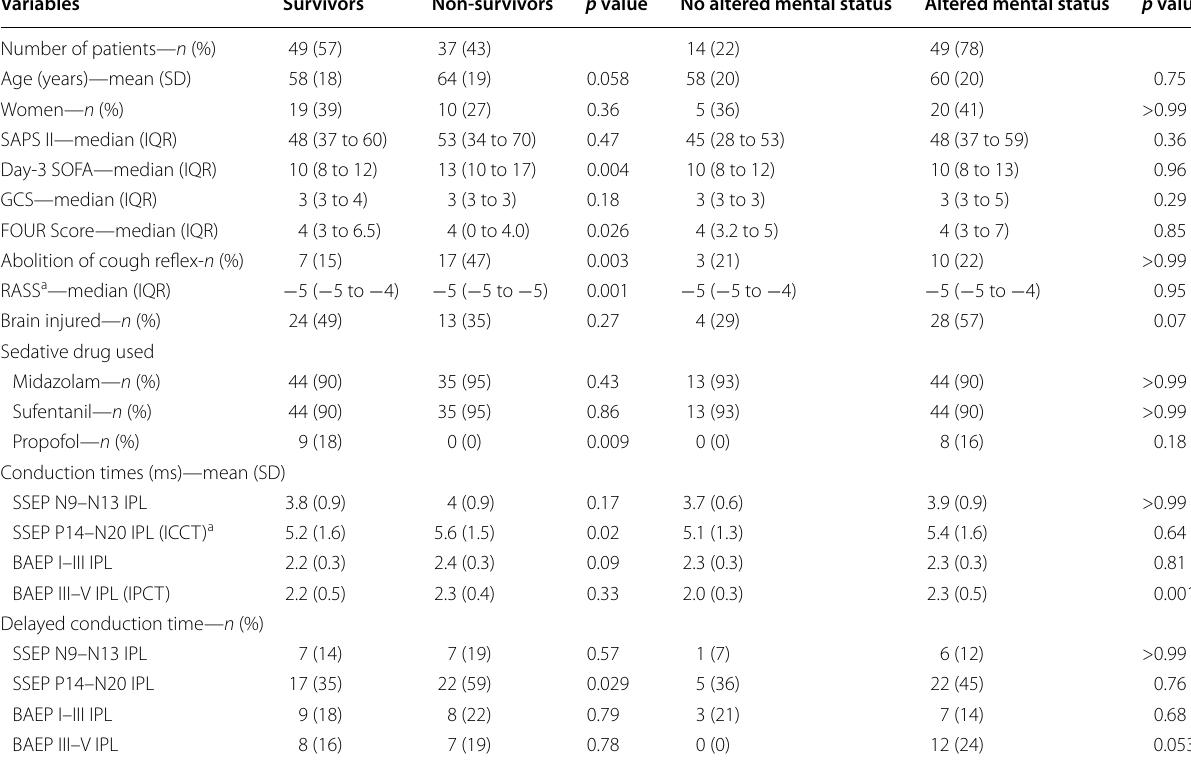
Table 4 Comparison of clinical and neurophysiological abnormalities among outcome categories